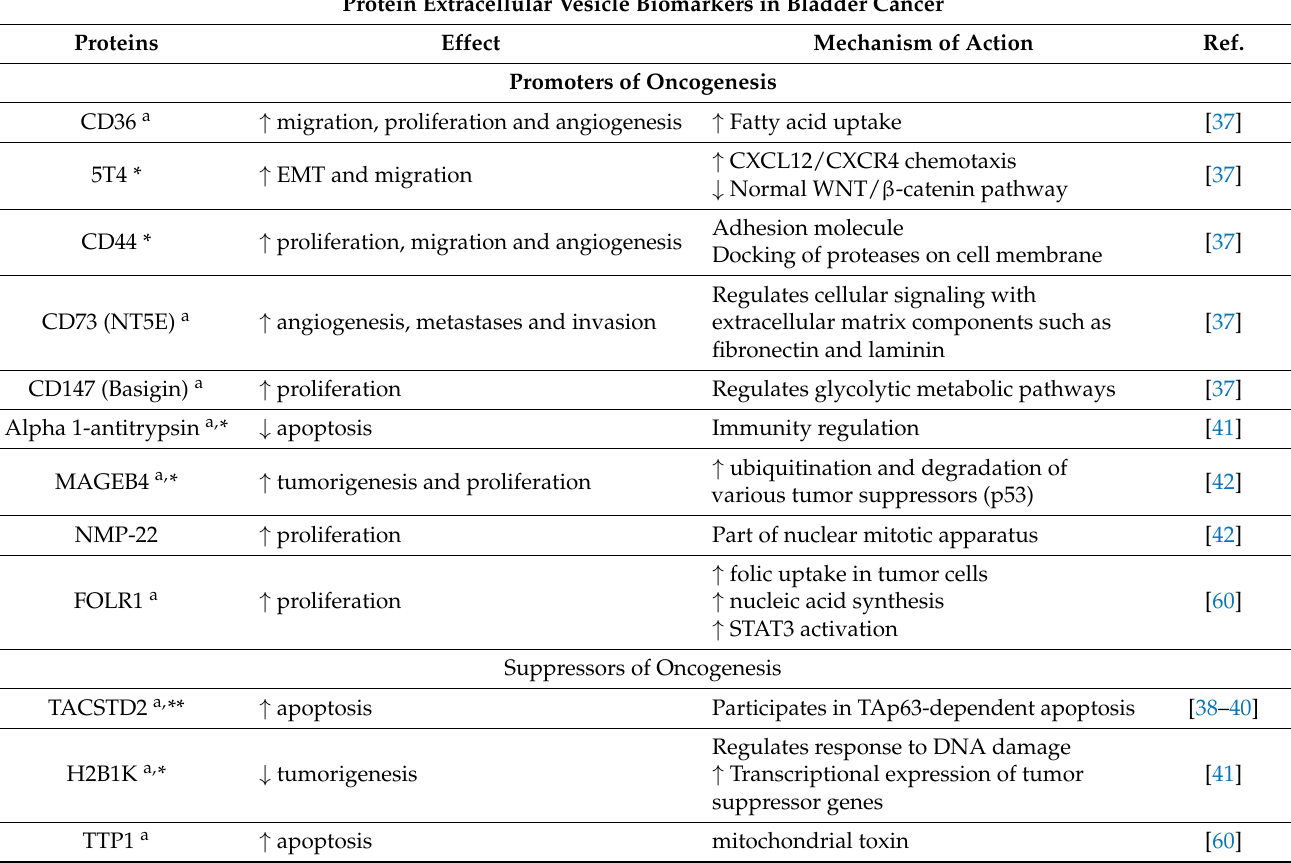
Table 1. Molecular pathways of EV protein biomarkers in bladder cancer pathogenesis. Protein Extracellular Vesicle Biomarkers in Bladder